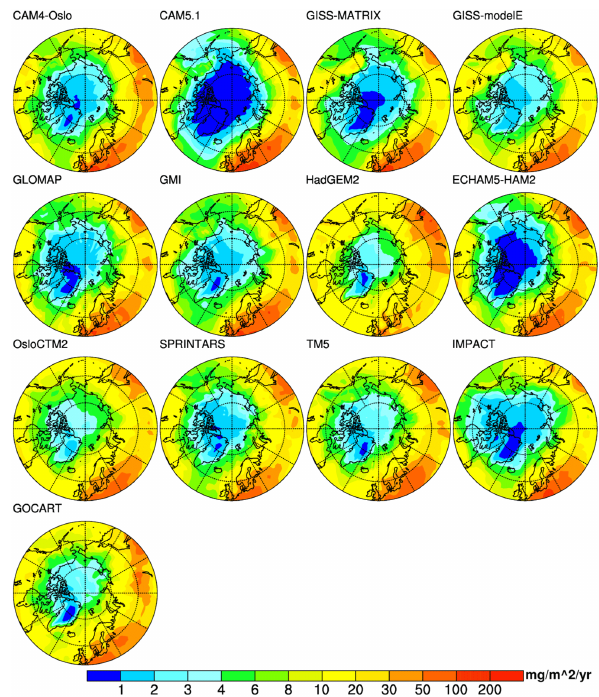
Fig. 8. Annual mean black carbon deposition fluxes for phase II models, plotted from 50 ◦ N to 90 ◦